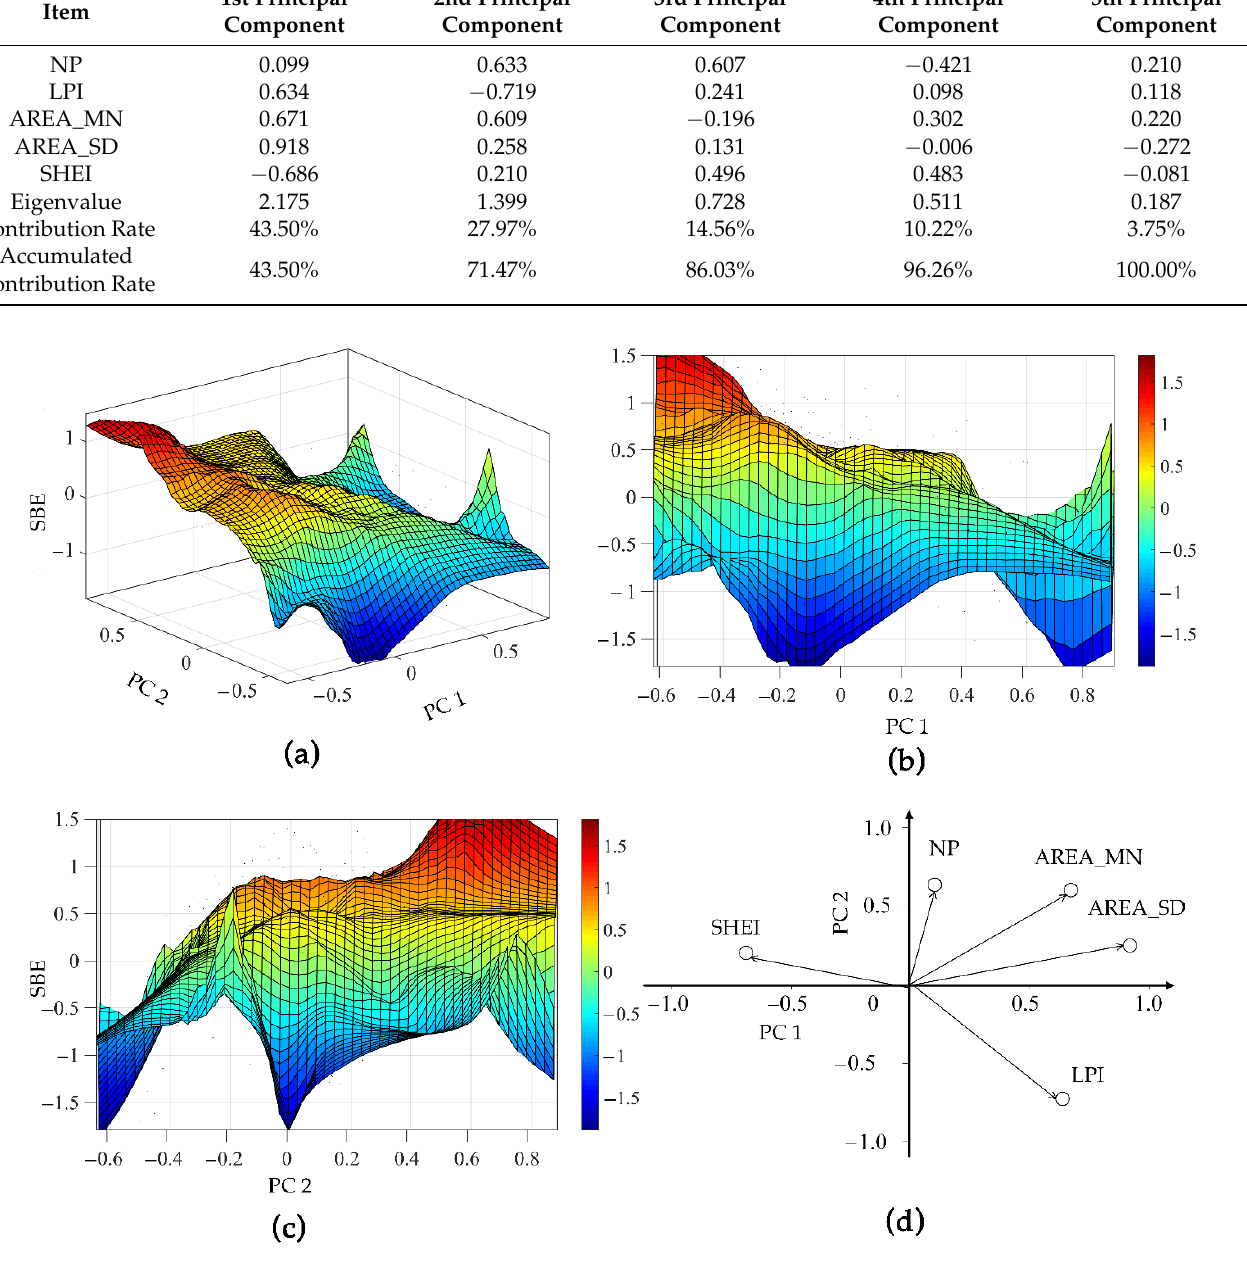
Figure 5. The influence trend of color pattern metrics and visual quality of the Cotinus coggygria var. cinerea Engl. forest. ( a ) The scattered plot and fitted surface of SBE with the first principal component (PC1) and the second principal component (PC2); ( b ) the projection of the fitted surface in the plane of PC1 and SBE; ( c ) the projection of the fitted surface in the plane of PC2 and SBE; ( d ) the factor loadings of metrics on PC1 and PC2.